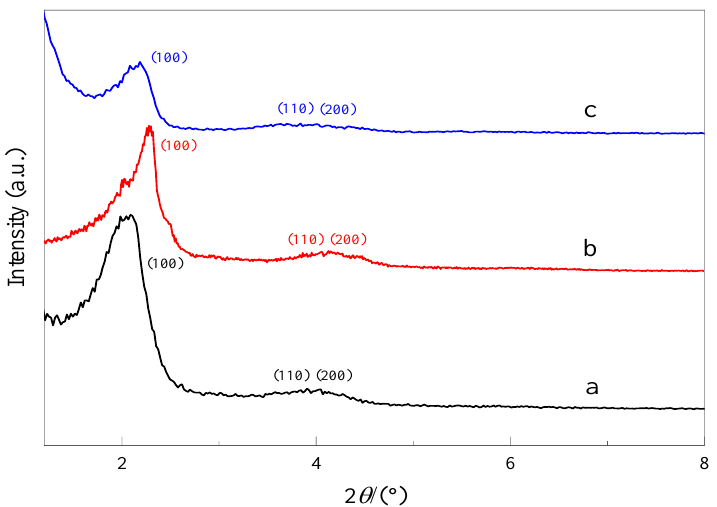
Figure 6. X-ray diffraction patterns of the samples. a -Mesoporous material synthesized with Gem- ini ionic liquid surfactant [N 1116 C 3 IMC 16 ][Br] 2 as template. b -Mesoporous material synthesized with Gemini ionic liquid surfactant [N 1116 C 3 N 1116 ][Br] 2 as template. c -Mesoporous material synthe- sized with Gemini ionic liquid surfactant [C 16 IMC 3 C 16 IM][Br] 2 as template. Table 3. Pore structure parameters of samples.